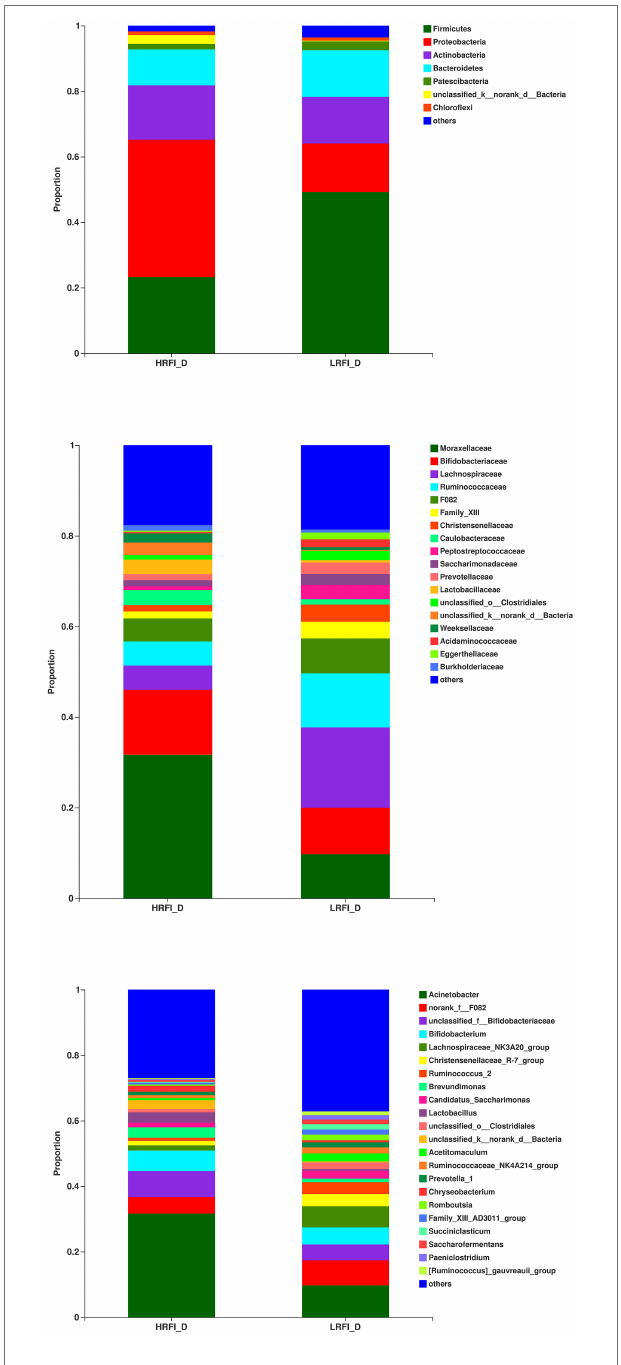
FIGURE 2 | The average proportion of the most dominant duodenum bacteria phyla, families, and genera (relative abundance >1% for all